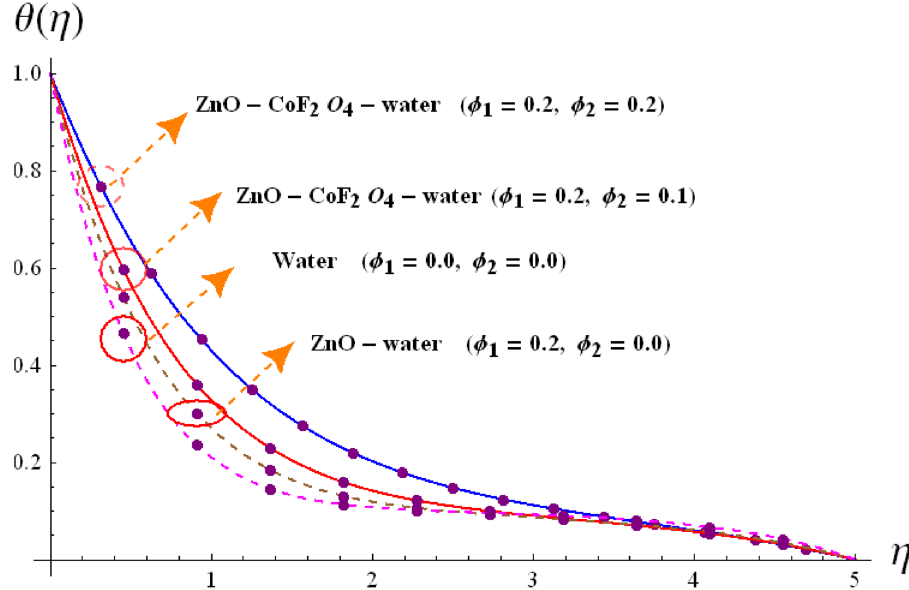
Figure 8. Variation of θ(η) via φ 1 /φ 2 .